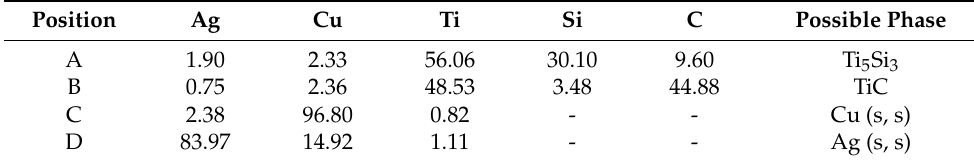
Figure 3. Microstructure and elemental distribution of SiC/AgCuTi/SiC joint brazed at 900 °C for 10 min ( a ) microstructure of joint, and ( b – f ) elemental distributions. Table 1. The EDS analysis results of the various phases in the joint shown in Figure 2b (at.